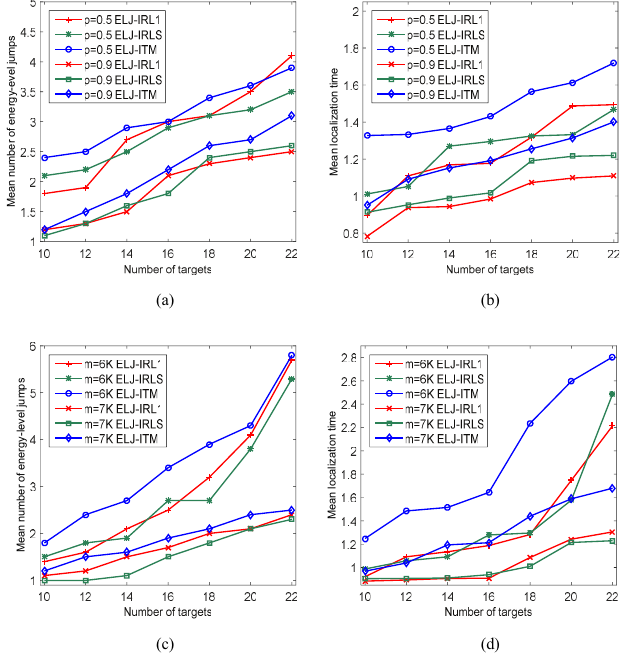
Figure 9. Performance analysis for ELJ using different local recovery algorithms. ( a ) Comparison of the mean number of energy-level jumps of ELJ-IRL1, ELJ-IRLS and ELJ-ITM for the different number of targets when m = 7 K . ( b ) Comparison of the mean localization time of ELJ-IRL1, ELJ-IRLS and ELJ-ITM for the different number of targets when m = 7 K . ( c ) Comparison of the mean number of energy-level jumps of ELJ-IRL1, ELJ-IRLS and ELJ-ITM for the different number of targets when p = 0.7. ( d ) Comparison of the mean localization time of ELJ-IRL1, ELJ-IRLS and ELJ-ITM for the different number of targets when p =